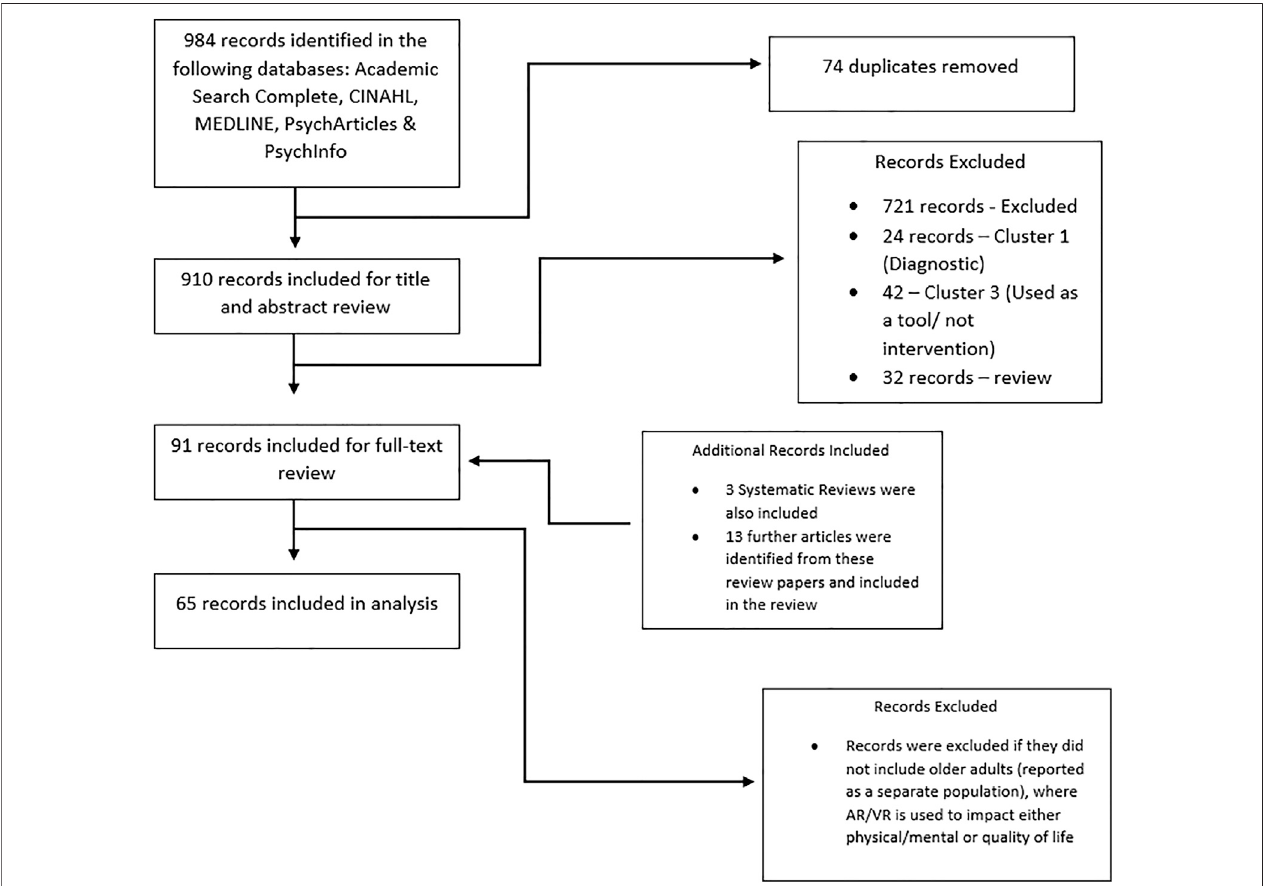
FIGURE 1 | Scoping Review-Augmented/Virtual Interventions - Study Flow Chart.